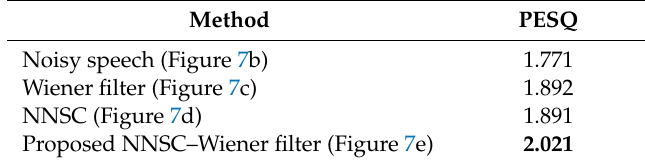
Figure 7. Spectrograms for a sample sentence pertaining to ( a ) clean speech, ( b ) speech in babble noise at an SNR of 0 dB, and those for the speech signals processed using ( c ) 𝐺 𝑘 ( ℓ ) ( d ) NNSC processing with results based on [17], and ( e ) the proposed method based on 𝐺 𝑘(1) (ℓ) . Table 3. The PESQ scores pertaining to the spectrograms shown in Figure